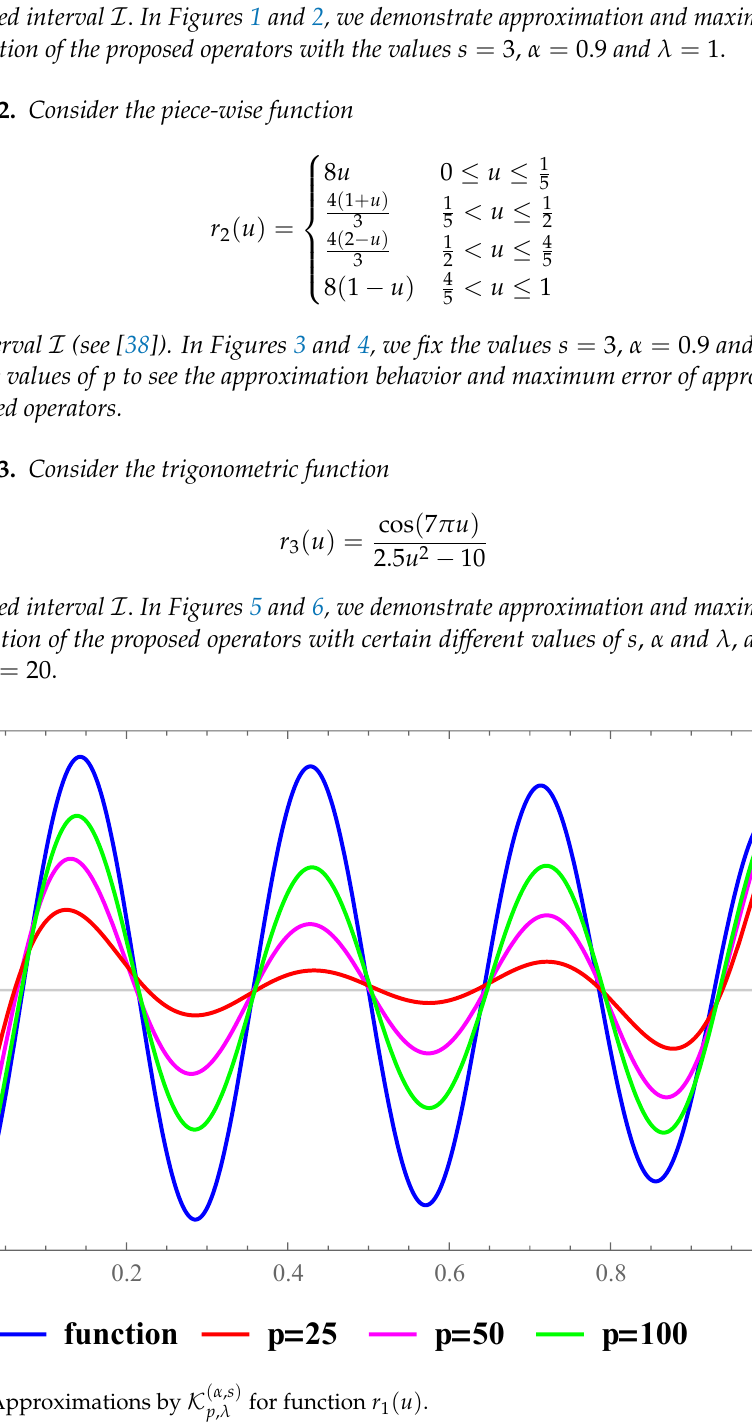
Figure 1. Approximations by K